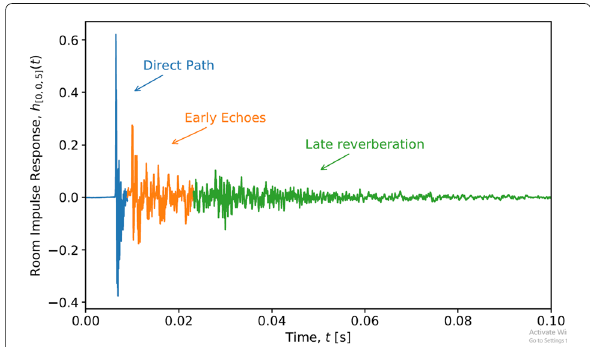
Fig. 1 Example of room impulse response from dEchorate